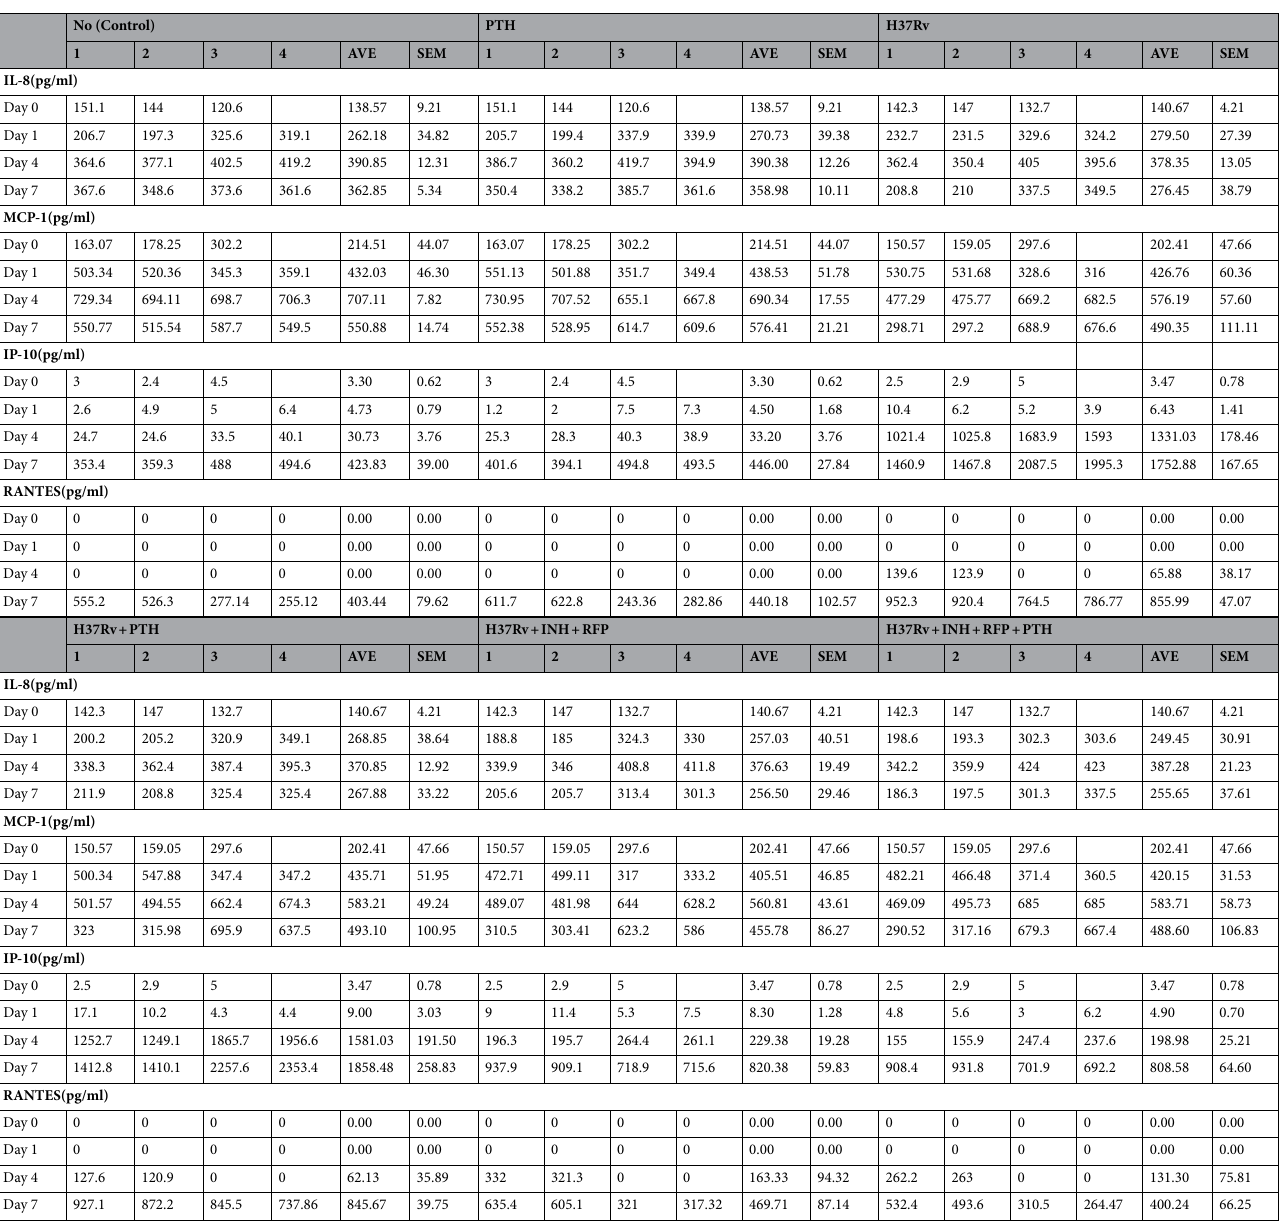
Table 4. Enzyme-linked immunosorbent assay (ELISA) of inflammatory chemokines. IL-8, interleukin-8; IP-10, interferon γ-induced protein 10 kDa; MCP-1, monocyte chemoattractant protein-1;RANTES, regulated upon activation, normal T cell expressed and presumably